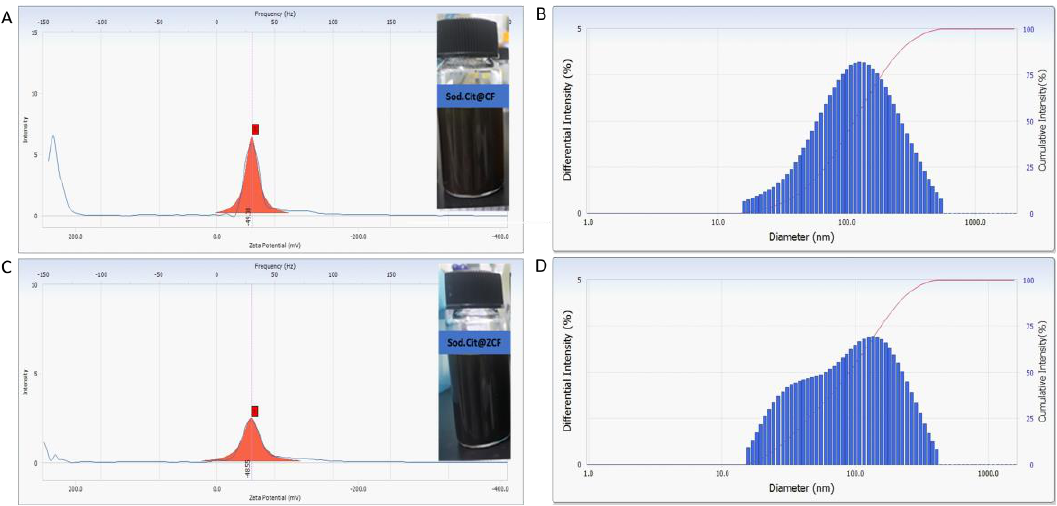
Figure 12. Dynamic light scattering (DLS) and zeta potential results for sodium citrate@ CF-MNPs ( A , B ) and sodium citrate@ ZCF-MNPs ( C , D ).